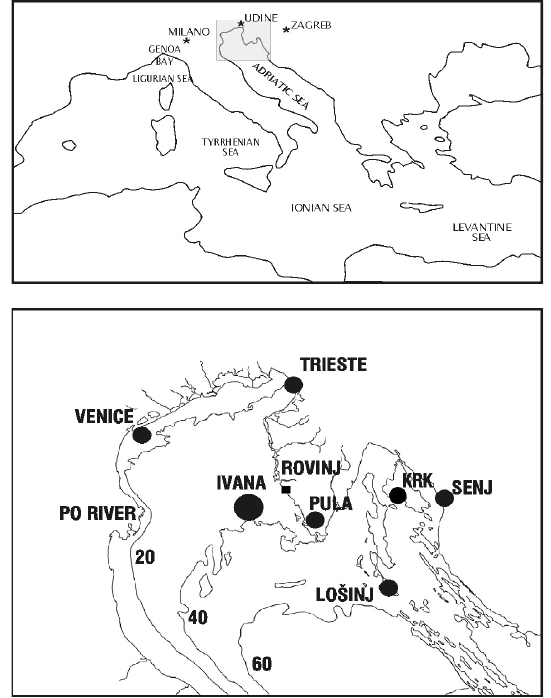
Fig. 1. Northern Adriatic Sea location and bathymetry. The loca- tions of the radio-sounding stations are denoted in the upper chart with asterisks, whereas the locations of the gas field Ivana and mete- orological stations whose data were used in the analysis are denoted with full circles on the lower